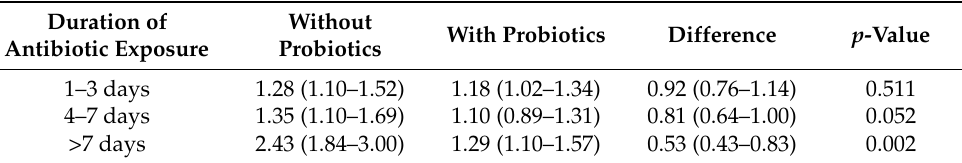
Table 4. Adjusted odds ratios * for hospitalisation, with and without probiotics, and their difference in a multiplicative